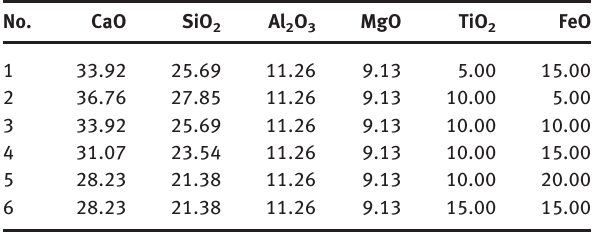
Table 1: Chemical composition of the primary slag, wt%. No. CaO SiO 